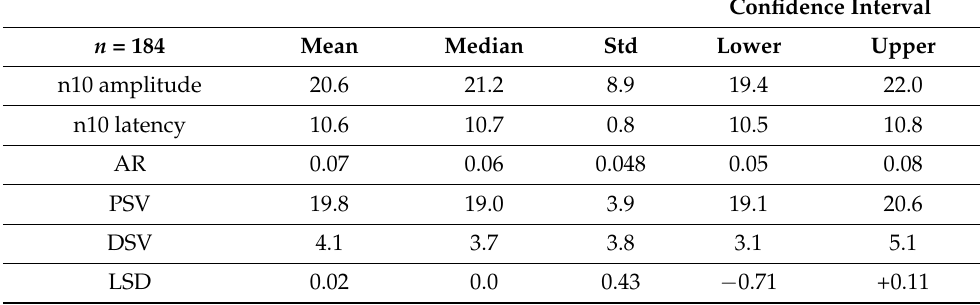
Table 2. Normative data (mean, median, and standard deviation (std)) with a confidence interval of 92 volunteers divided into 184 measurements of n10 amplitude, n10 latency, and asymmetric ratio (AR) with novel parameters of phase synchronization vector (PSV), delta shift-vector (DSV), and latency shift difference (LSD).